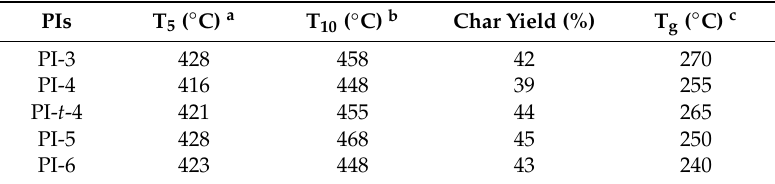
Table 3. Thermal properties of poly(imide)s.